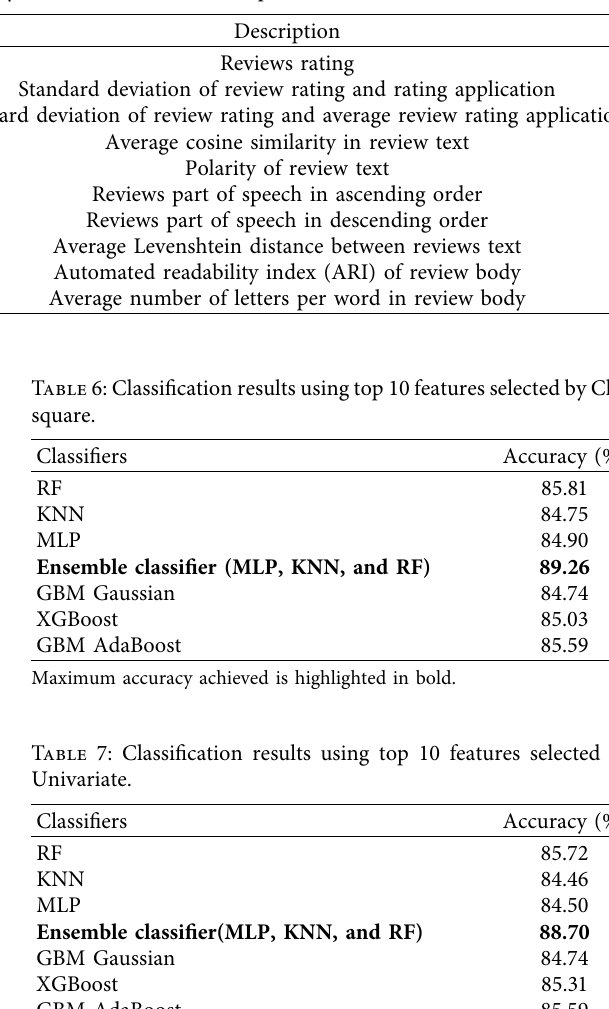
Maximum accuracy achieved is highlighted in